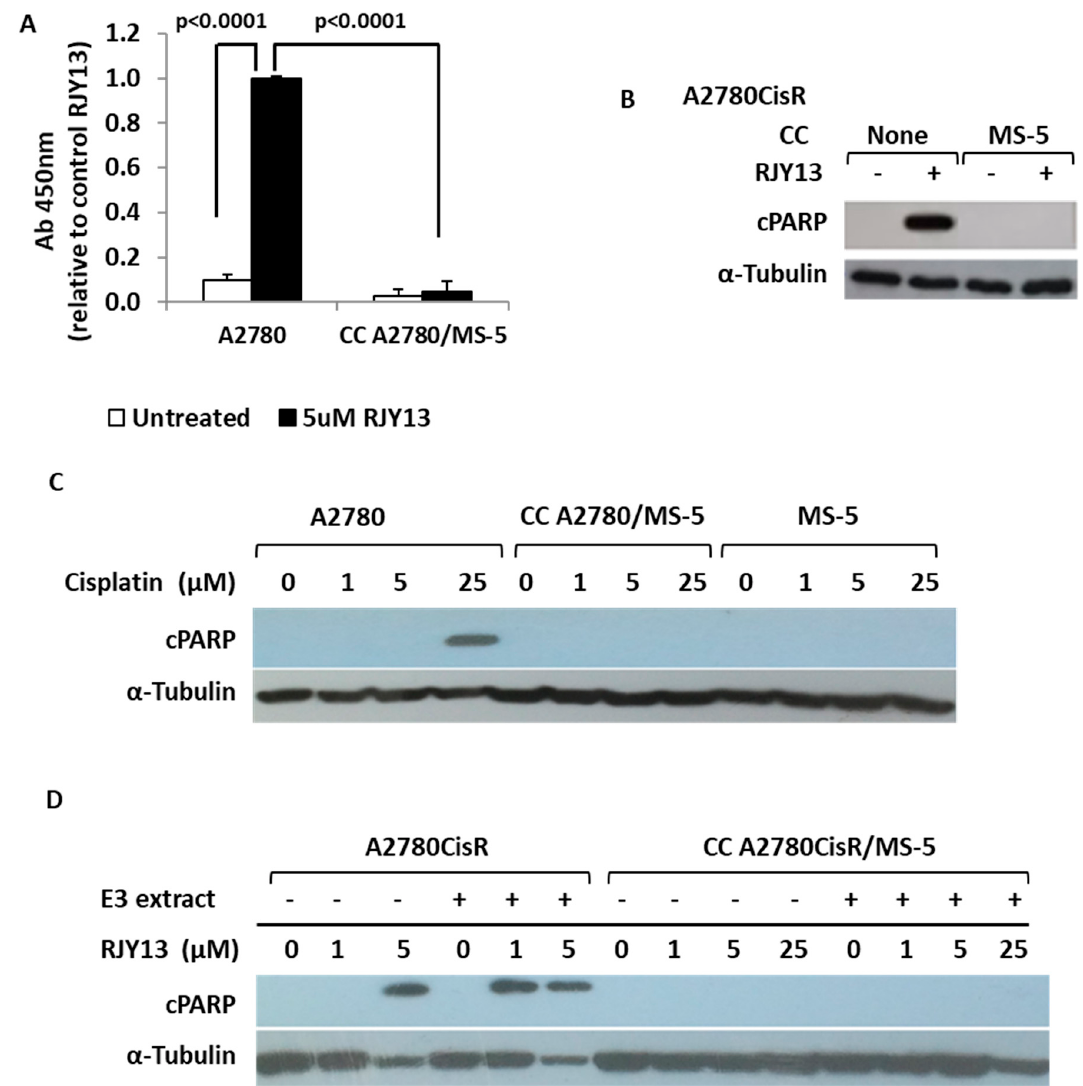
Figure 1. MS-5 confers drug resistance to ovarian cancer (OC) cells. ( A ) OC cisplatin-sensitive cells (A2780) were exposed to 5 μ M of RJY13 in the presence and absence of MS-5 and levels of cleaved polymerase (PARP) were monitored by PARP ELISA kit. ( B ) OC cisplatin resistant cells (A2780CisR) were exposed to 5 μ M of RJY13 in the presence and absence of MS-5 and levels of cleaved PARP were monitored by immunoblotting. ( C ) OC cisplatin sensitive cells (A2780) were exposed to different concentrations (1-25 μ M) of cisplatin in the presence and absence of MS-5 and levels of cleaved PARP were monitored by immunoblotting. ( D ) OC cisplatin resistant cells (A2780CisR) were exposed to 1 or 5 μ M of RJY13 in the presence and absence of MS-5 and levels of cleaved PARP were monitored by immunoblotting. A2780cisR co-cultured with MS-5 were also exposed to 1, 5, and 25 μ M of RJY13 in the presence and absence of oriental mistletoe extract (E3 extract) at 50 μ g/mL (D). α -Tubulin was used as a loading control. CC, co-culture.